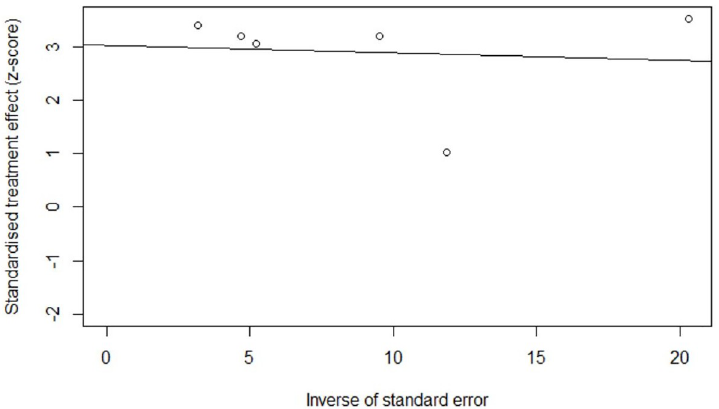
Fig 6. Publication bias assessment: Radial plot for post hoc meta-analysis of tuberculosis and risk of cardiovascular disease and related mortality.